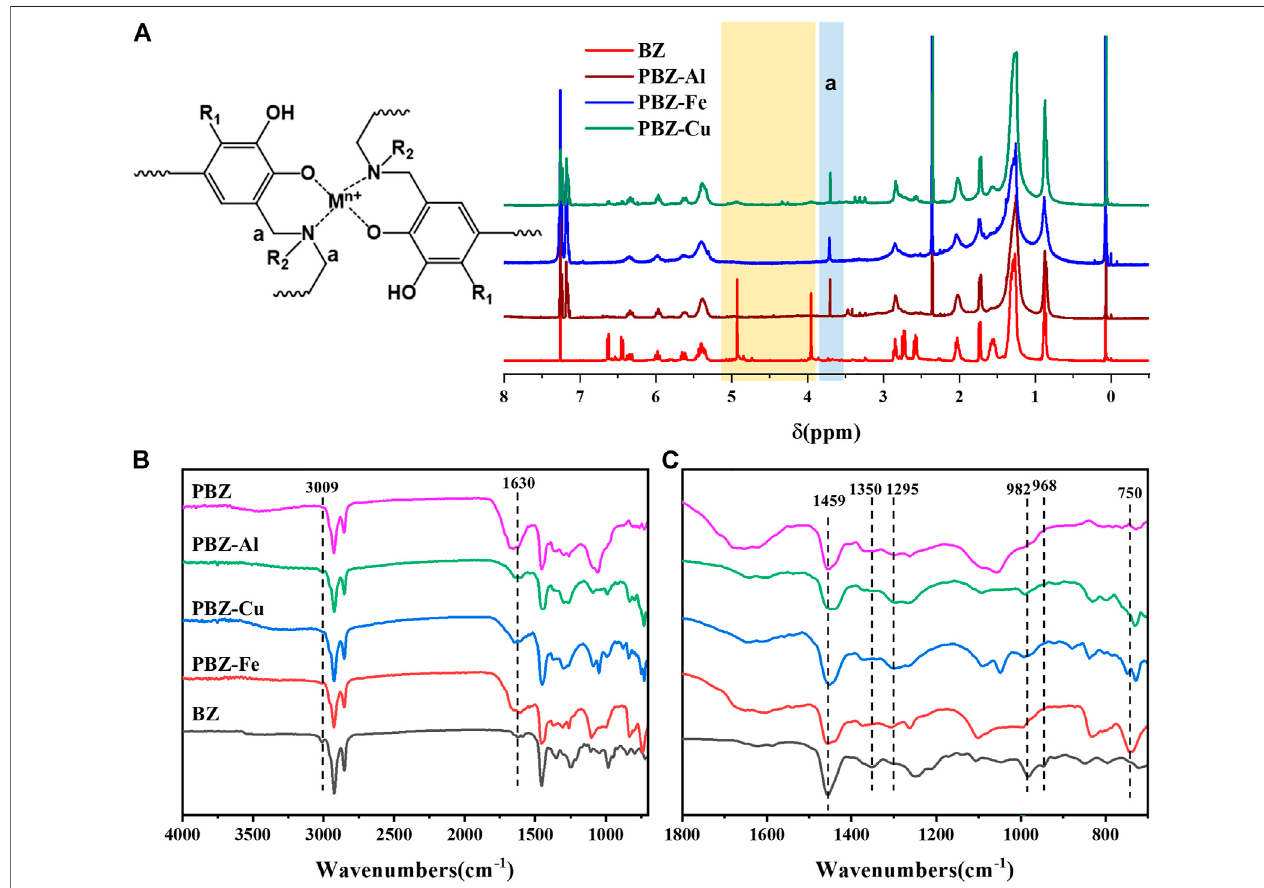
FIGURE 3 | NMR (A) and ATR-FTIR (B,C) spectrum of BZ and PBZ-M.